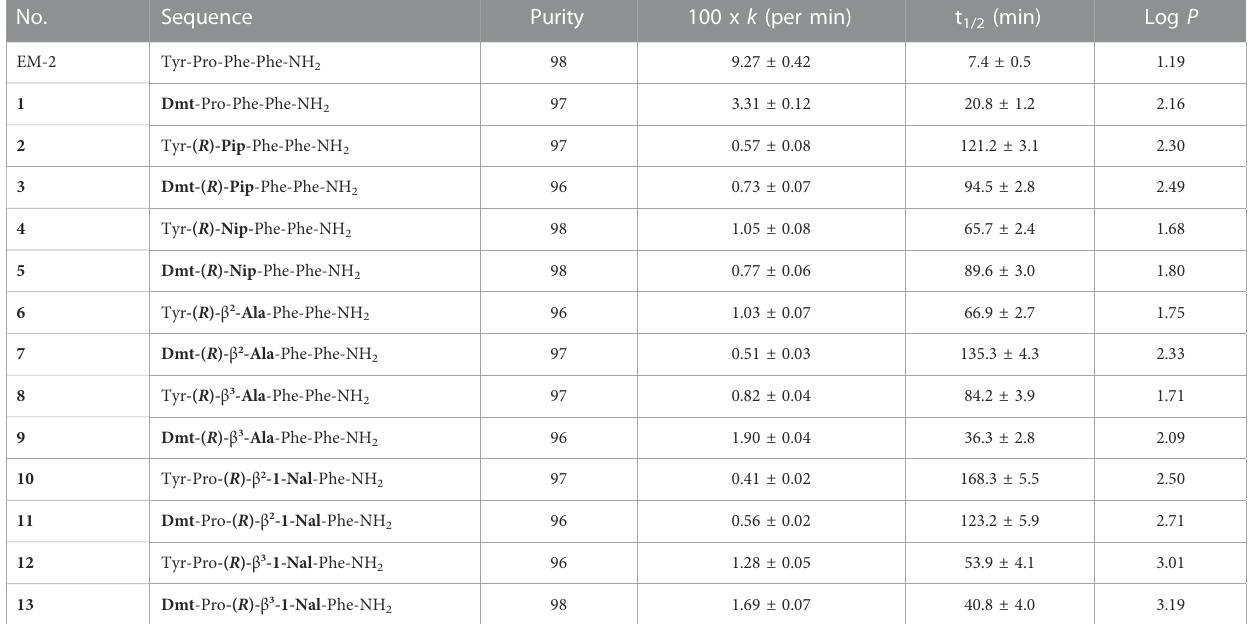
TABLE 1 Enzymatic stability and lipophilicity (log P ) of EM-2 analogs. No.